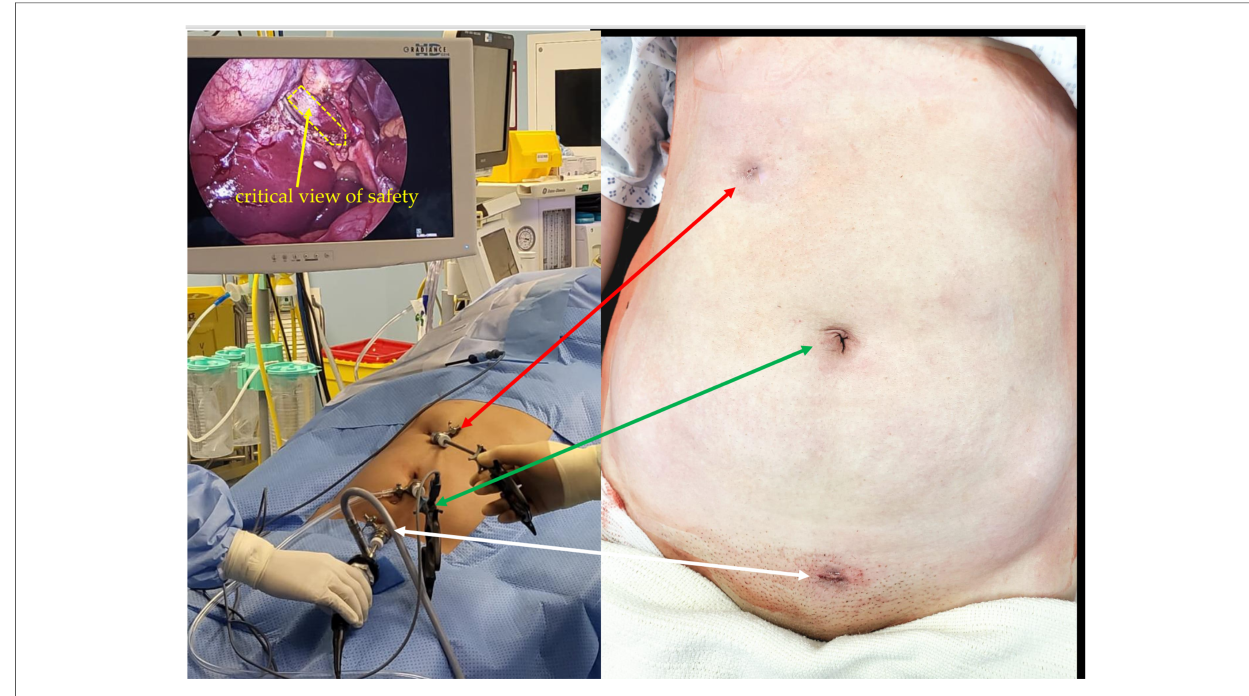
FIGURE 3 Emirate laparoscopic cholecystectomy showing all 5 mm port positions and fi nal non-visible